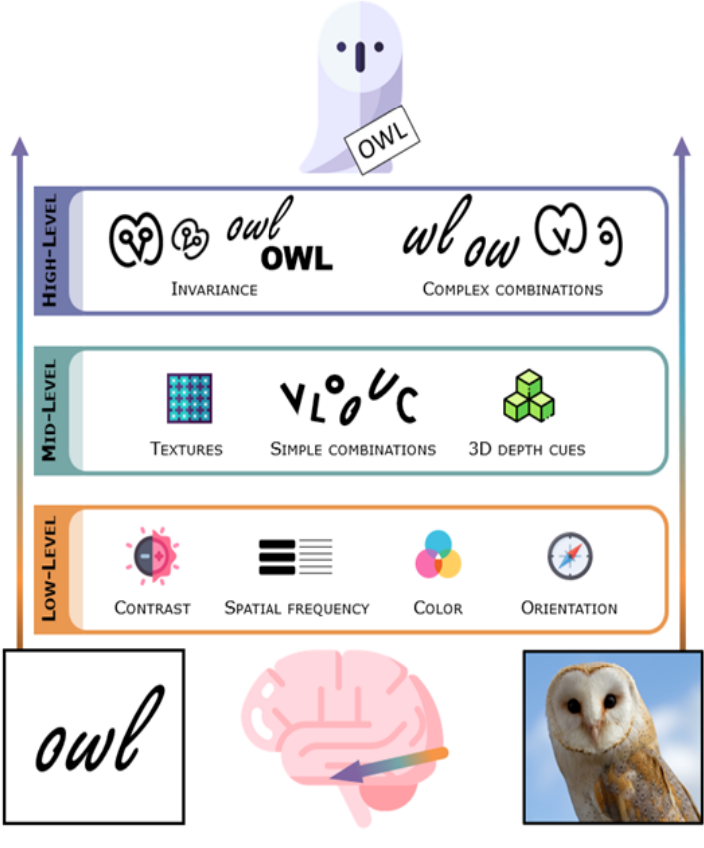
Figure 1. Simplified schematic of the hierarchical view of vision based on studies in humans and animals. Visually presented words are generally believed to go through the entire visual processing hierarchy [46]: low-level (contrast, spatial frequencies, color or orientation), mid-level (simple con- junctions of visual features without necessarily being driven by any of the constituent parts [47]) and high-level (combinations of mid-level features as complex shapes [43] and tolerance or invari- ance to identity-preserving transformations [41,48,49]). Words likely share low- and mid-level fea- tures with various objects. Words and other object classes may, however, recruit specialized high- level visual features as they are not necessarily characteristic of all object types, and this might need to be learned through experience [50]. Figure inspired by figures from Groen et al. [51] and Dehaene et al. [46], icons by the current authors or by Flaticon.com, owl picture by Tony Hisgett, under a CC BY 2.0 license: https://creativecommons.org/licenses/by/2.0/ (accessed on 20 September 2021). Visual words, just like all other visual objects, go through extensive processing along this cortical hierarchy [52], and high-level regions of the ventral visual stream are im- portant for visual word recognition. Damage to the left fusiform gyrus and adjacent tissue can give rise to severe reading problems [53 – 55], and such reading problems can be tran- siently induced when parts of the left fusiform gyrus and the adjoining inferior temporal gyrus are deactivated. These problems are quite specific, as several other functions such as spontaneous speech, auditory comprehension, and writing are spared by stimulation of several of the implanted electrodes [56]. The neuronal recycling hypothesis [57] sup- poses that because of experience with reading, these regions are recycled for the purpose of recognizing written words. The recycling hypothesis furthermore assumes that such cortical plasticity is constricted by the evolutionary history of the cortex. In other words, these regions are selected for recycling because visual word recognition demands certain neural characteristics that these cortical areas happen to have [57]; see also [58 – 60]. The character-selective cortical region that has gained the greatest attention is the visual word form area (VWFA) which has been the focus of several studies on developmental dyslexia.